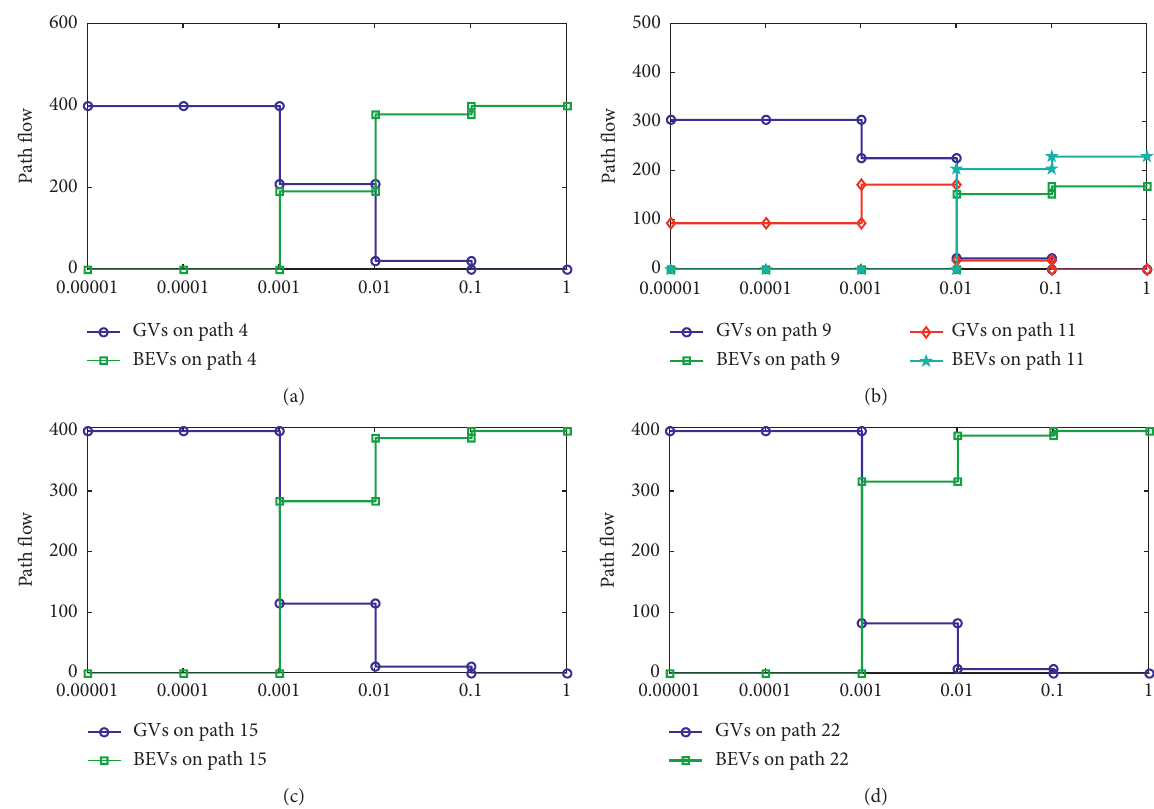
Figure 7: Changing unit operating cost of GVs in Nguyen–Dupuis’ network. (a) O-D pair (1, 2). (b) O-D pair (1, 3). (c) O-D pair (4, 2). (d) O-D pair (4,